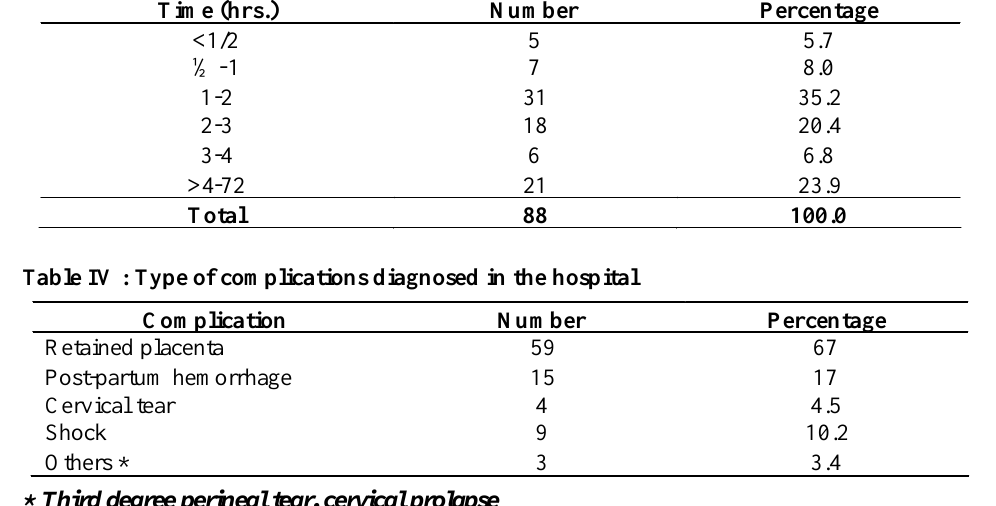
* Third degree perineal tear, cervical